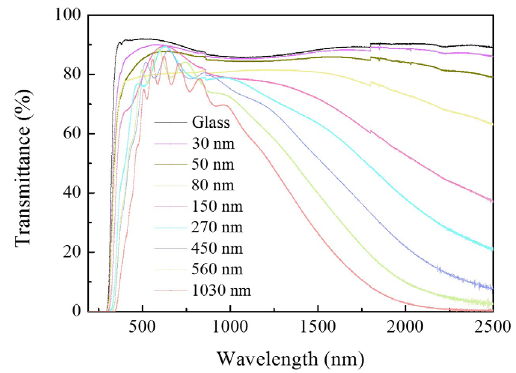
Figure 6. Optical transmittance spectra of the AZO films deposited onto glass substrates for different sputtering times. A typical spectrum of the glass substrate is also